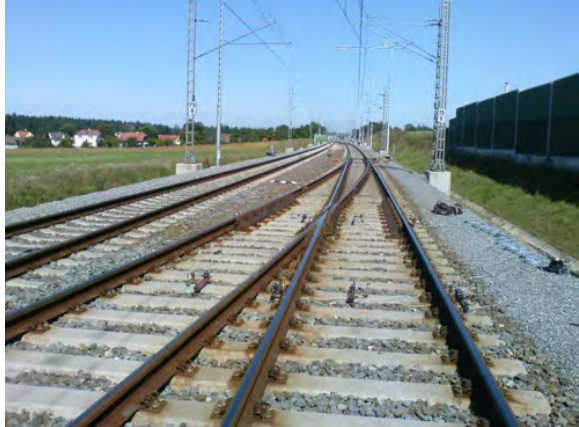
Figure 1. Test section in Plana nad Luznici railway station - under sleeper pads